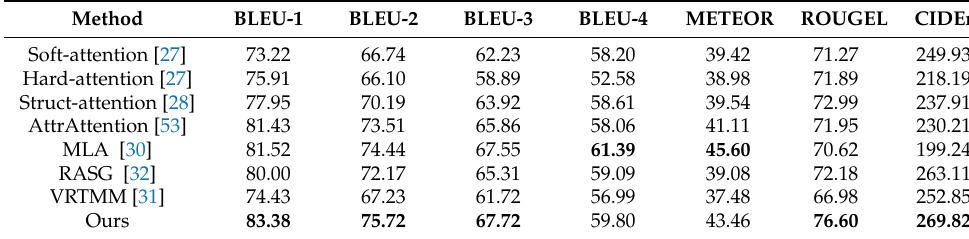
Table 2. Comparison scores (%) on Sydney data set.